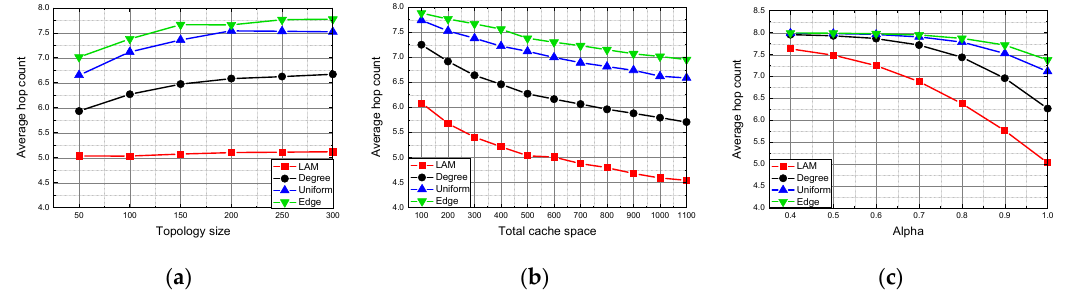
Figure 7. Performance of average hop count in cache allocation. (a)The average hop count under different topology sizes. (b)The average hop count under different total cache space. (c)The average hop count under different Zipf parameter Alpha.